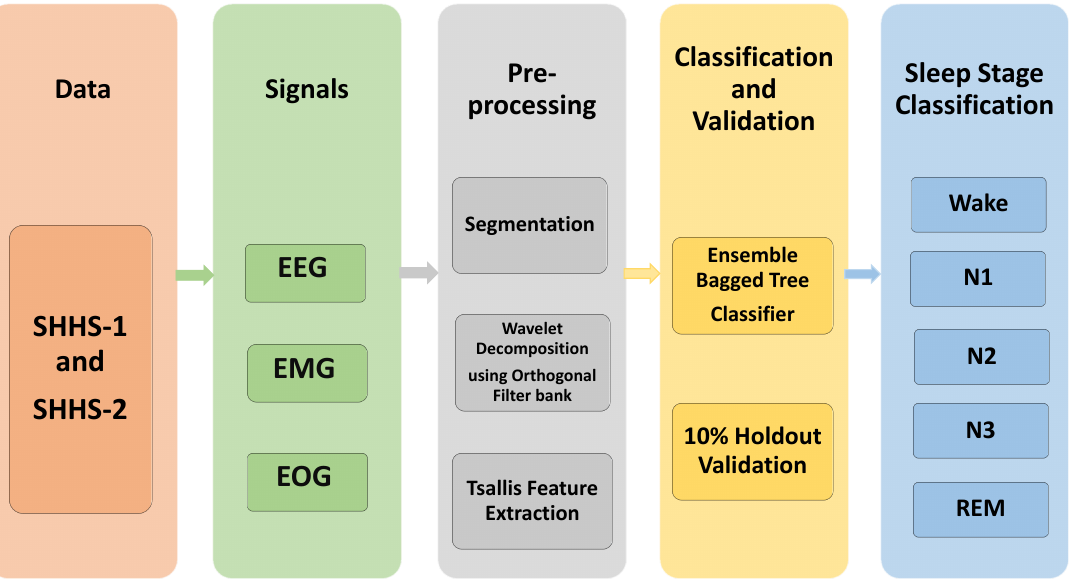
Figure 1. Block diagram of the proposed